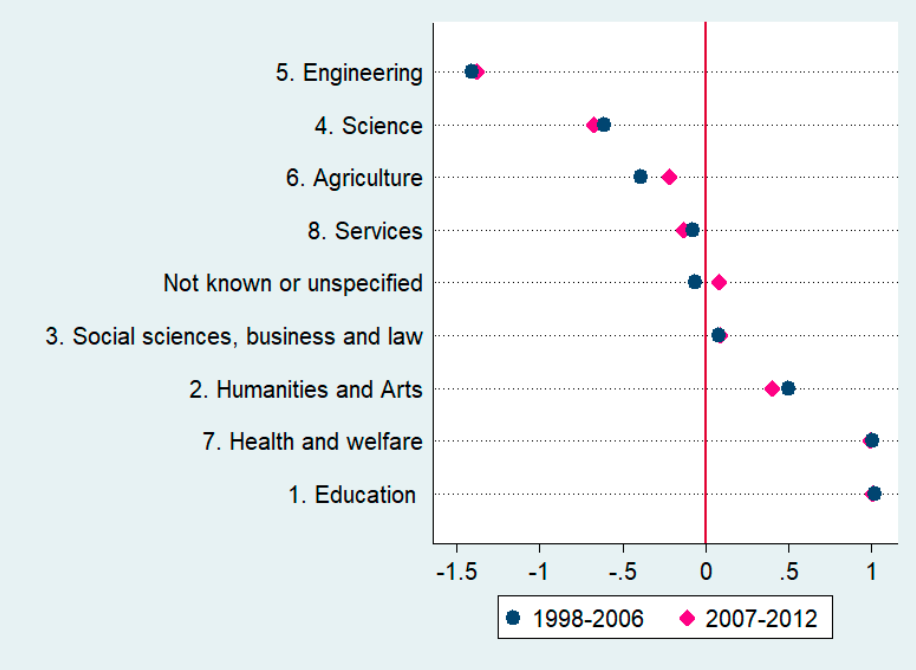
Figure 2. Field Segregation—Association Index.